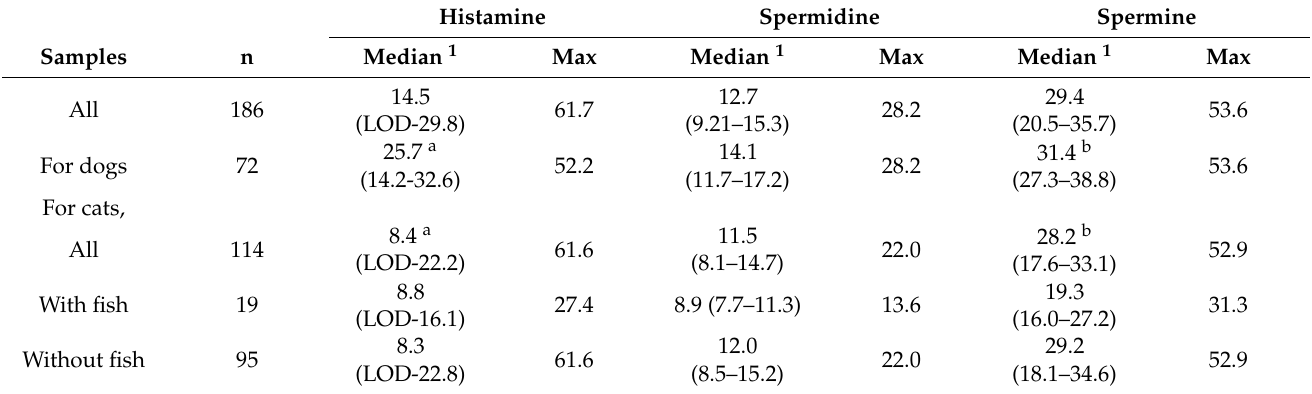
Table 1. Contents (mg/kg fresh weight) of histamine, tyramine, spermidine, and spermine in canned dog and cat food.